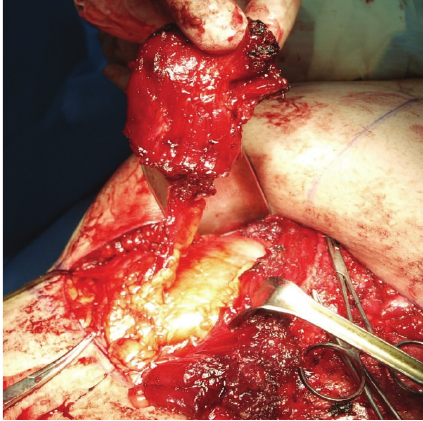
Figure 5: The rectus muscle flap with the distal penile shaft.